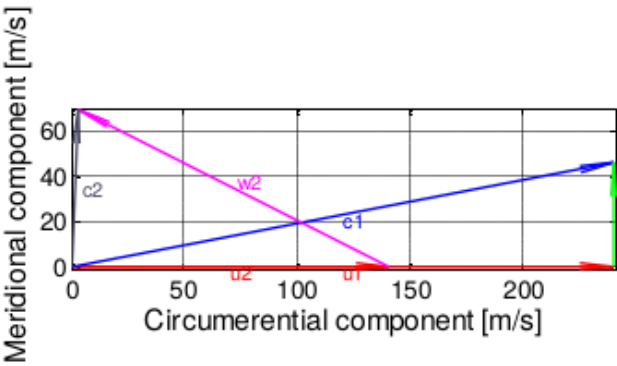
Figure 8: Kinematics of the centripetal stage.